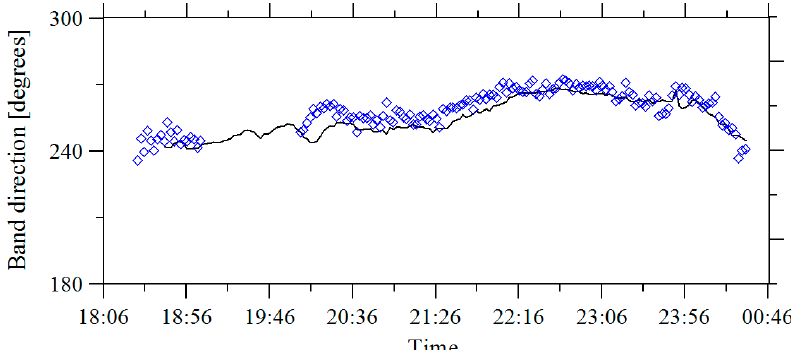
Figure 9. The band propagation direction Ds at a distance of 150 m from the SOP (black line) and the direction of the vector of the sum of the current speed in the upper layer and 3% of the wind speed (blue diamonds).